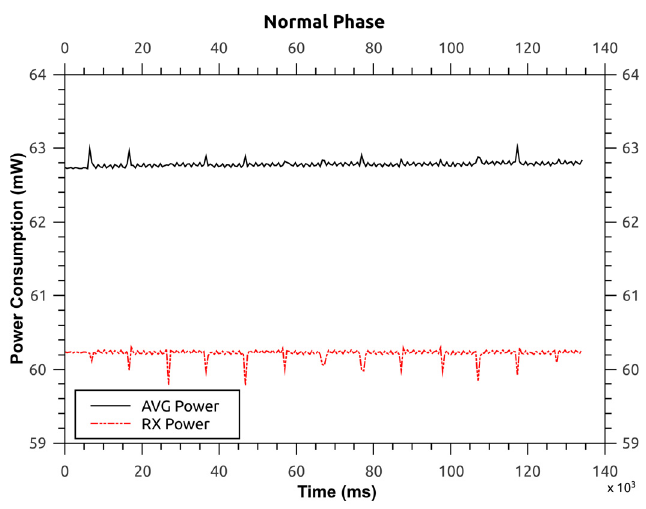
Figure 14. Power consumption for protocol—normal operation.